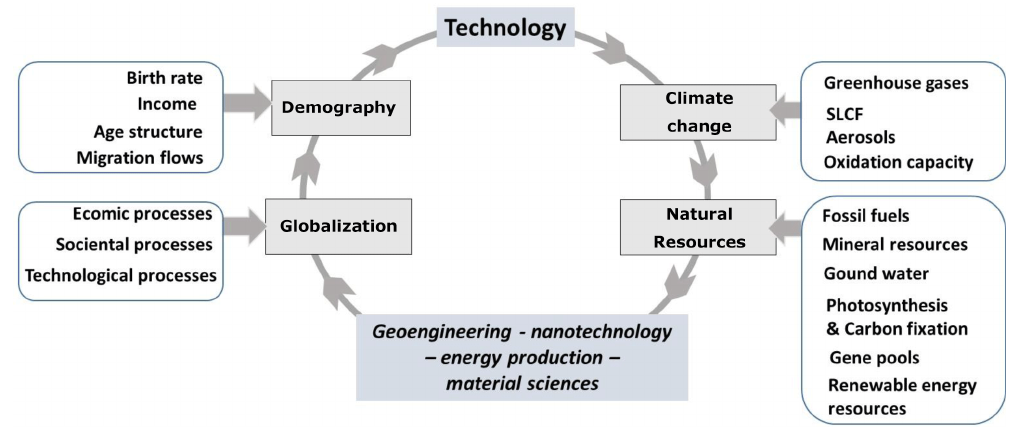
Figure 1. The interlinked global forces (climate change, natural resources, globalization, demography) (Smith, 2010) modifying the northern regions’ future within the next 40 years. The technological development provides the framework for the future development trends.